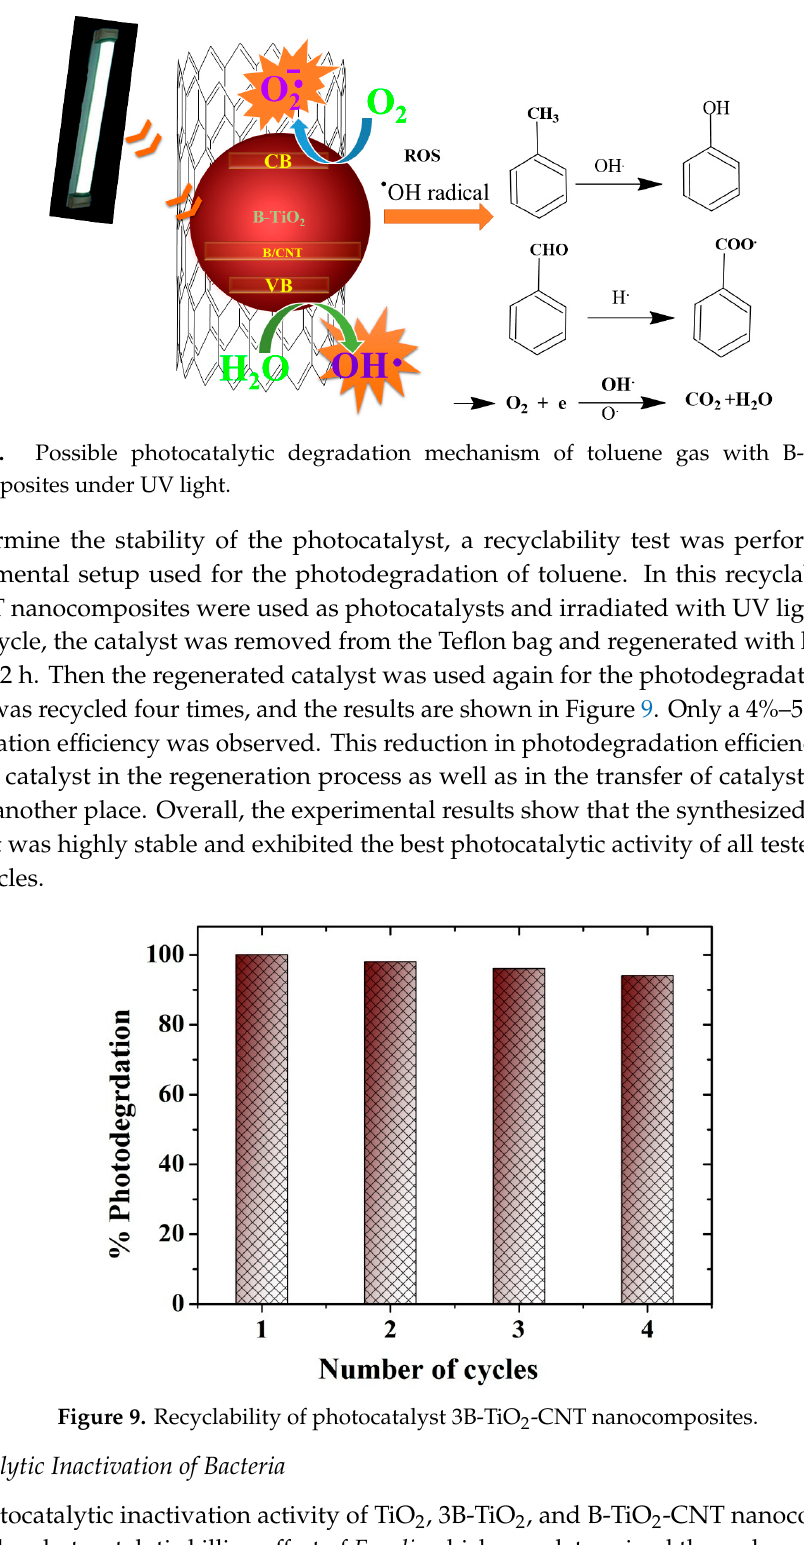
Figure 10. % survival of E. coli with of TiO 2 , 3B-TiO 2 and B-TiO 2 -CNT nanocomposites as a function of time.